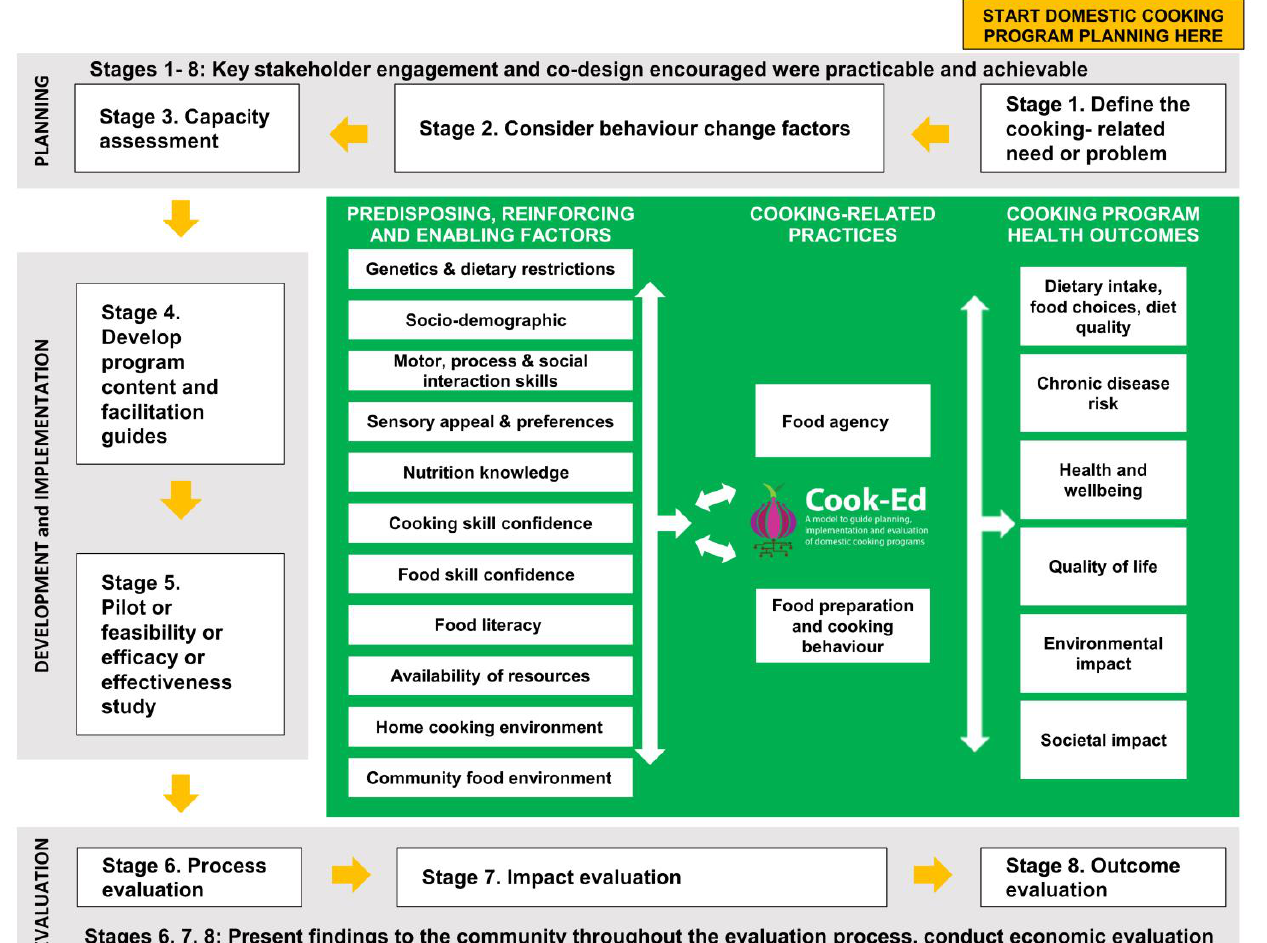
Figure 1. Proposed Cook-Ed TM model to guide planning, implementation and evaluation of cooking education curricula for domestic cooking programs to improve diet and health.